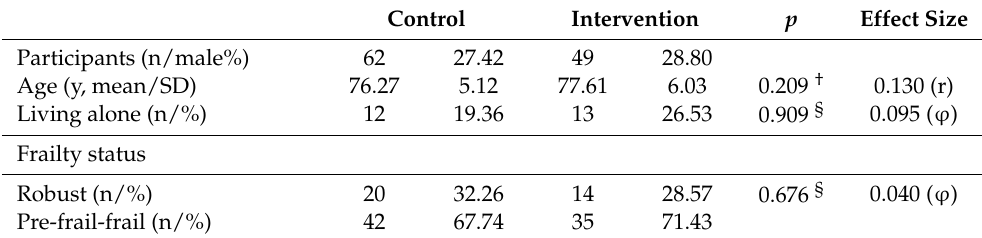
Table 2. Characteristics of the study participants at baseline.